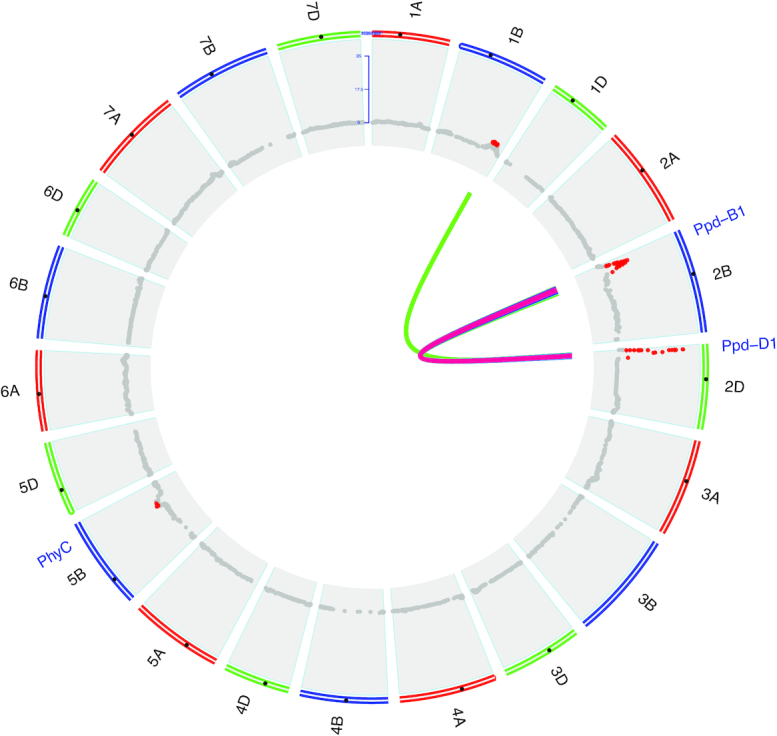
Genetic analysis of heading date scored by deep learning. Genome-wide association testing for heading date measured by deep learning on the Lakin × Fuller recombinant inbred line testing for 21 wheat chromosomes. Markers above Bonferroni multiple-test correction threshold shown in red. Epistatic interactions (internal connections) for 2-gene interaction model. Significant interactions at Bonferroni correction shown with heat colors indicating significance level (logarithm of the odds range from 4.97 [blue] to 22.4 [red]).